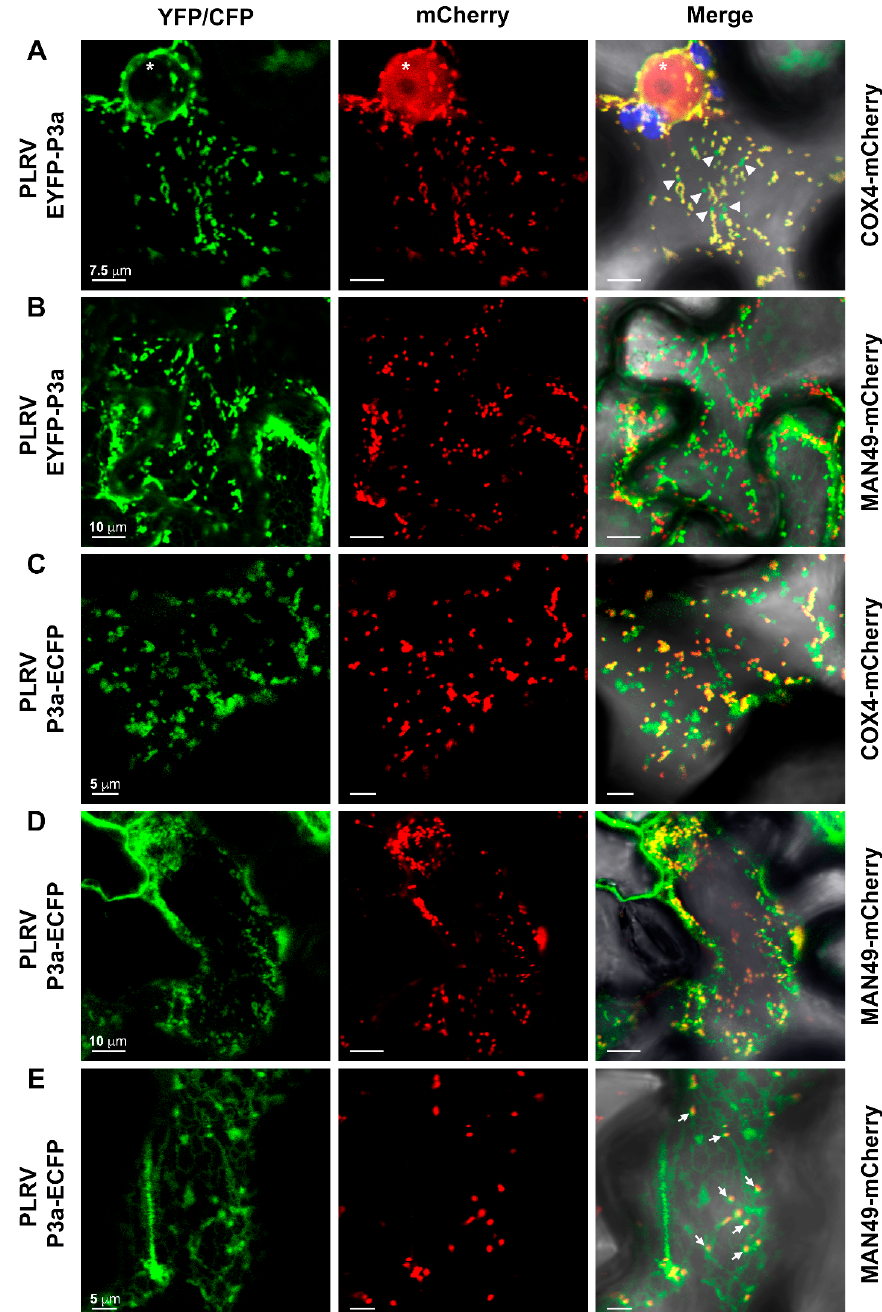
Figure 8. Tag orientation of a full-length fluorescent protein fusion influences the localization pattern of PLRV P3a. The panels represent single-plane confocal micrographs of N. benthamiana leaf epidermal cells co-expressing ( A , B ) PLRV EYFP-P3a or ( C , D ) P3a-ECFP with ( A , C ) COX4-mCherry or ( B , D , E ) MAN49-mCherry. EYFP/ECFP fluorescence is falsely colored green with mCherry fluorescence in red. The overlap of EYFP/ECFP and mCherry fluorescence with the corresponding brightfield image is shown in the column labeled merge with co-localization of fluorescence appearing yellow. Chloroplast autofluorescence is highlighted in blue. White arrowheads indicate EYFP fluorescence independent of COX4-mCherry. A white asterisk marks the position of the nucleus. White arrows mark MAN49-mCherry labeled cis -Golgi partially co-localizing with P3a-ECFP at putative ER exit sites. Scale bars show the length indicated.